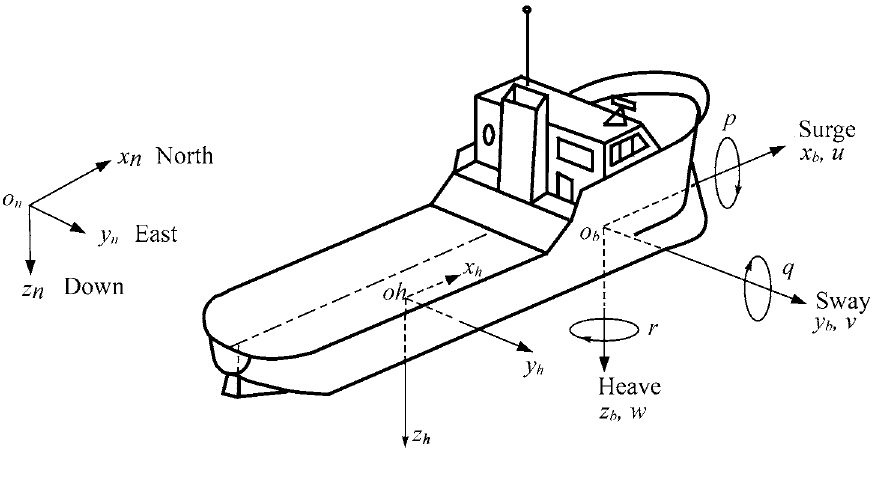
Figure 2. Notation and sign conventions for ship motion